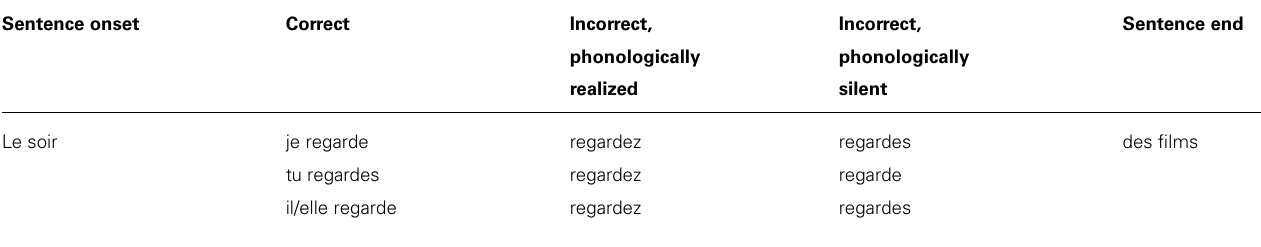
Table 2 | Examples of the three sentence conditions (correct, incorrect and orally realized, incorrect and silent) for the three singular verbal persons in French used in Experiment 2. Sentence